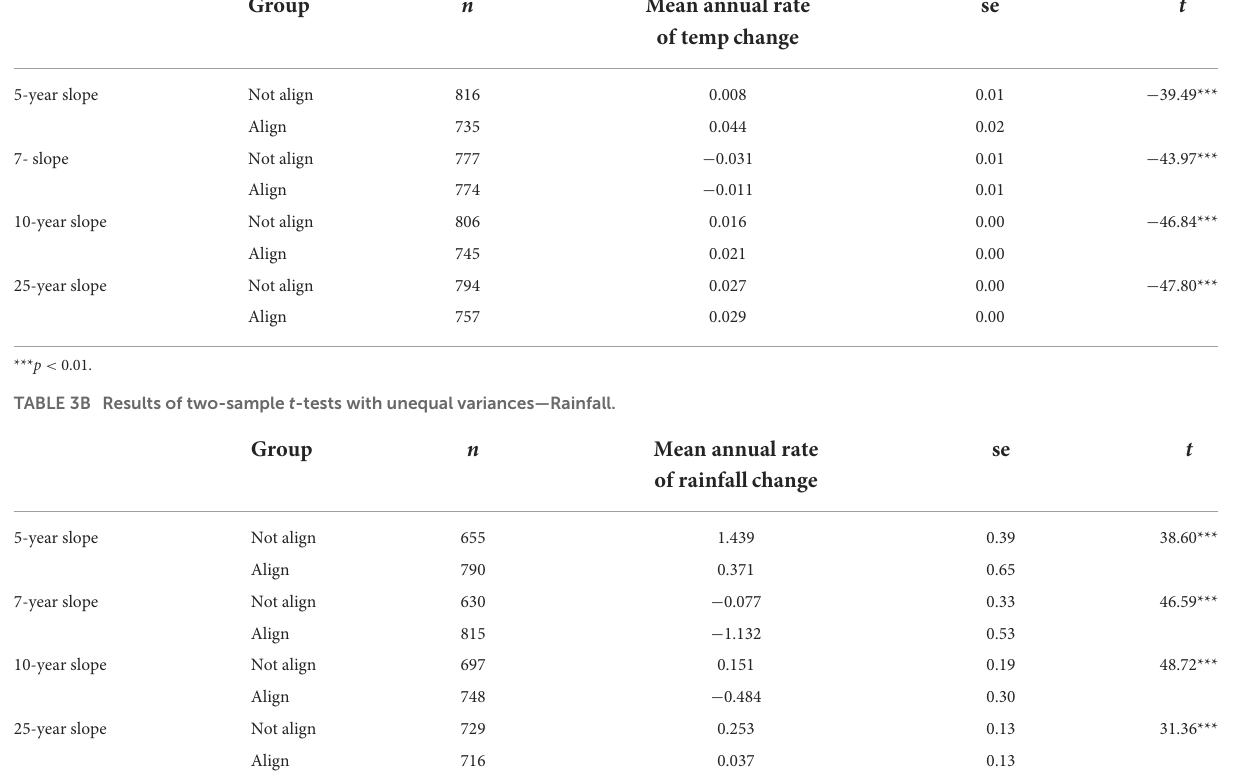
se t of temp change